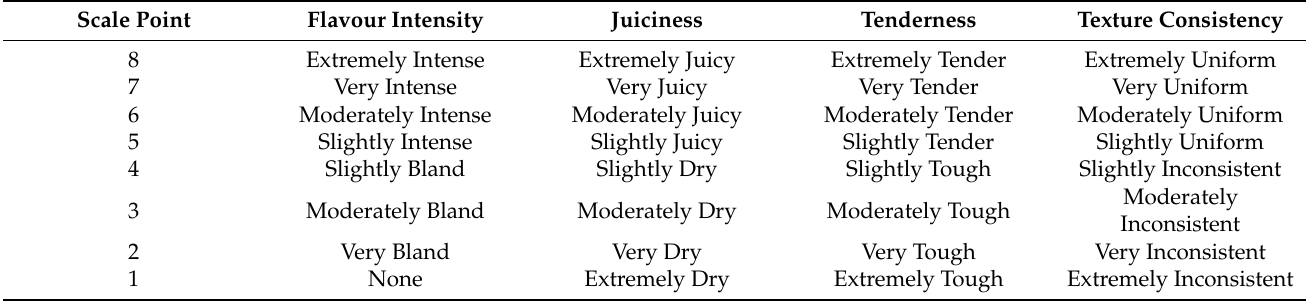
Table 2. Scale description for scoring sensory attributes evaluated by trained sensory panelists. Scale